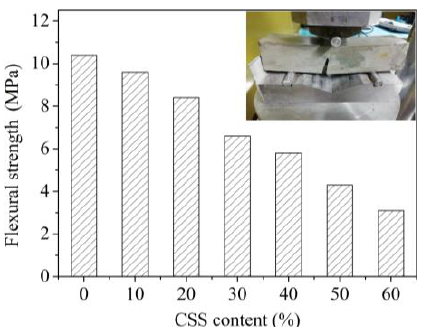
Figure 8. Flexural strength of the sample.